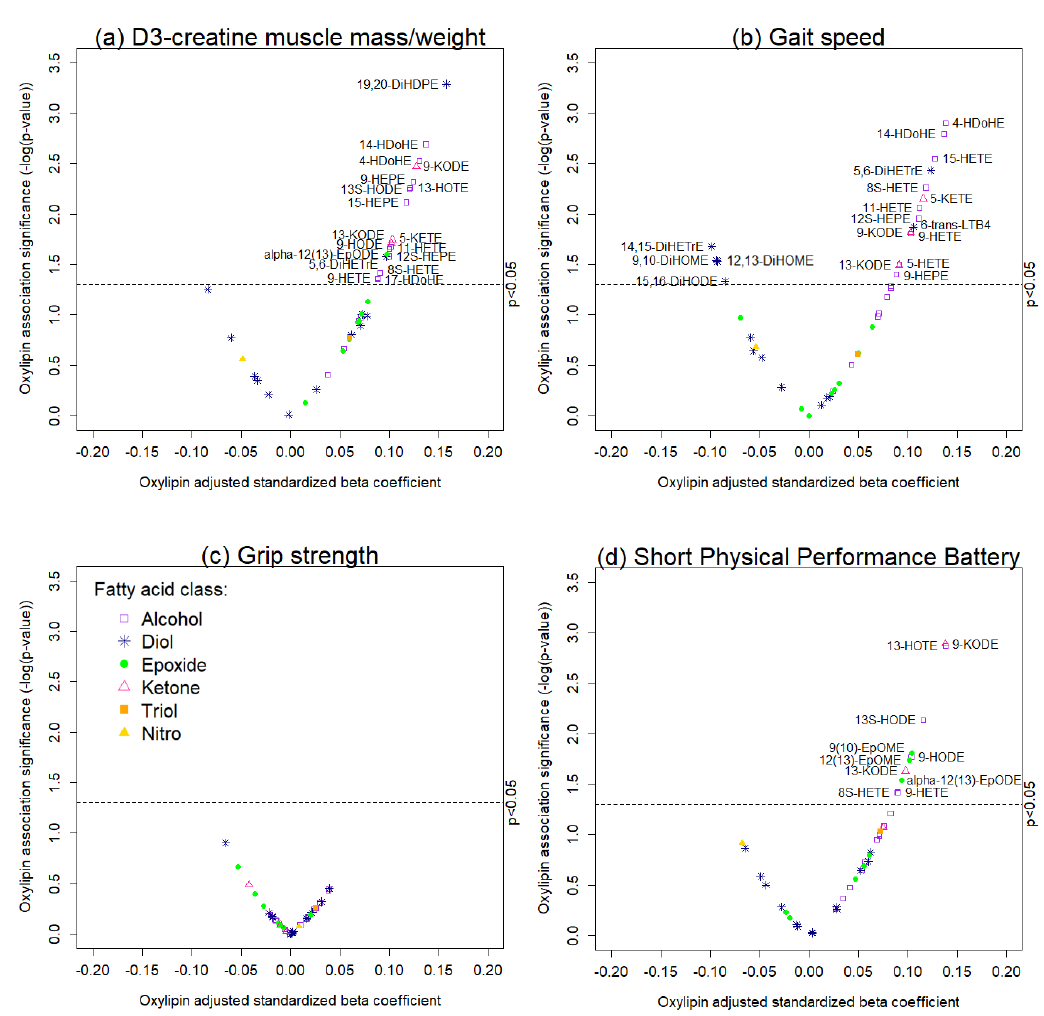
Figure 2. Significance vs. multivariable adjusted association between oxylipins and ( a ) D3-creatine muscle mass/weight, ( b ) gait speed, ( c ) grip strength, and ( d ) the Short Physical Performance Battery among 463 MrOS men. Models were adjusted for age, more than high school education, Physical Activity Scale for the Elderly, Western style dietary pattern score, and fish oil supplement use. Oxylipin abbreviations are listed in Table S2.